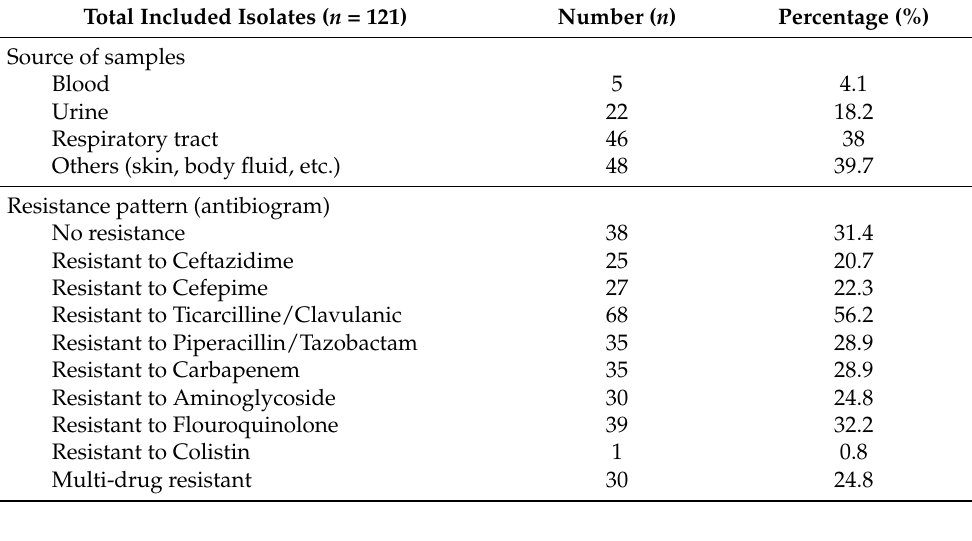
Table 3. Antimicrobial susceptibility test (AST) results of all P. aeruginosa isolates.